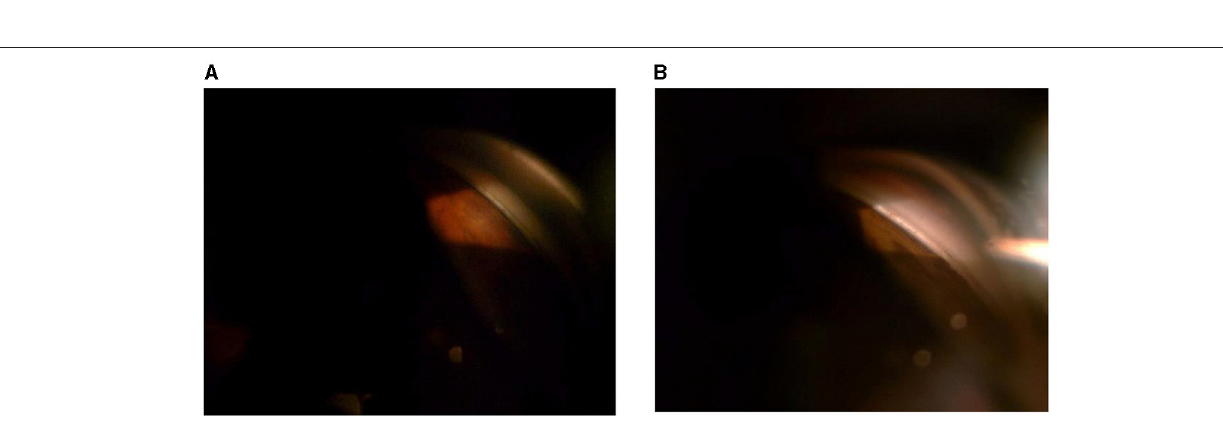
FIGURE 2 | (A,B) Appearance of the anterior chamber angle after microcatheter-assisted trabeculotomy combined with deep sclerectomy and trabeculectomy (MATT-DS-Trab) at 1 month (A) and at 12 months (B) after surgery.